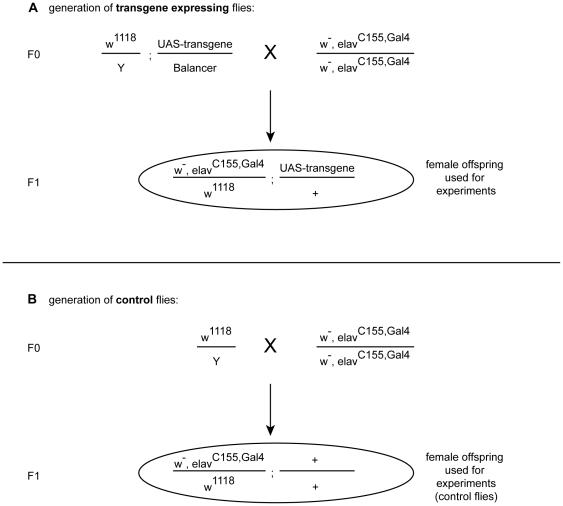
Generation of transgene expressing flies.Males from an UAS-transgene stock were mated with female virgins from the Gal4 line of interest. Female progeny hemizygous for the transgene and Gal4 were selected and used (A). Generation of control flies. Males from w1118 were mated with female virgins from the Gal4 line of interest. Female progeny hemizygous for the Gal4 were selected and used. W1118 flies are used for control crosses since the P-element insertion of the UAS-transgenes was done in w1118 flies (B).